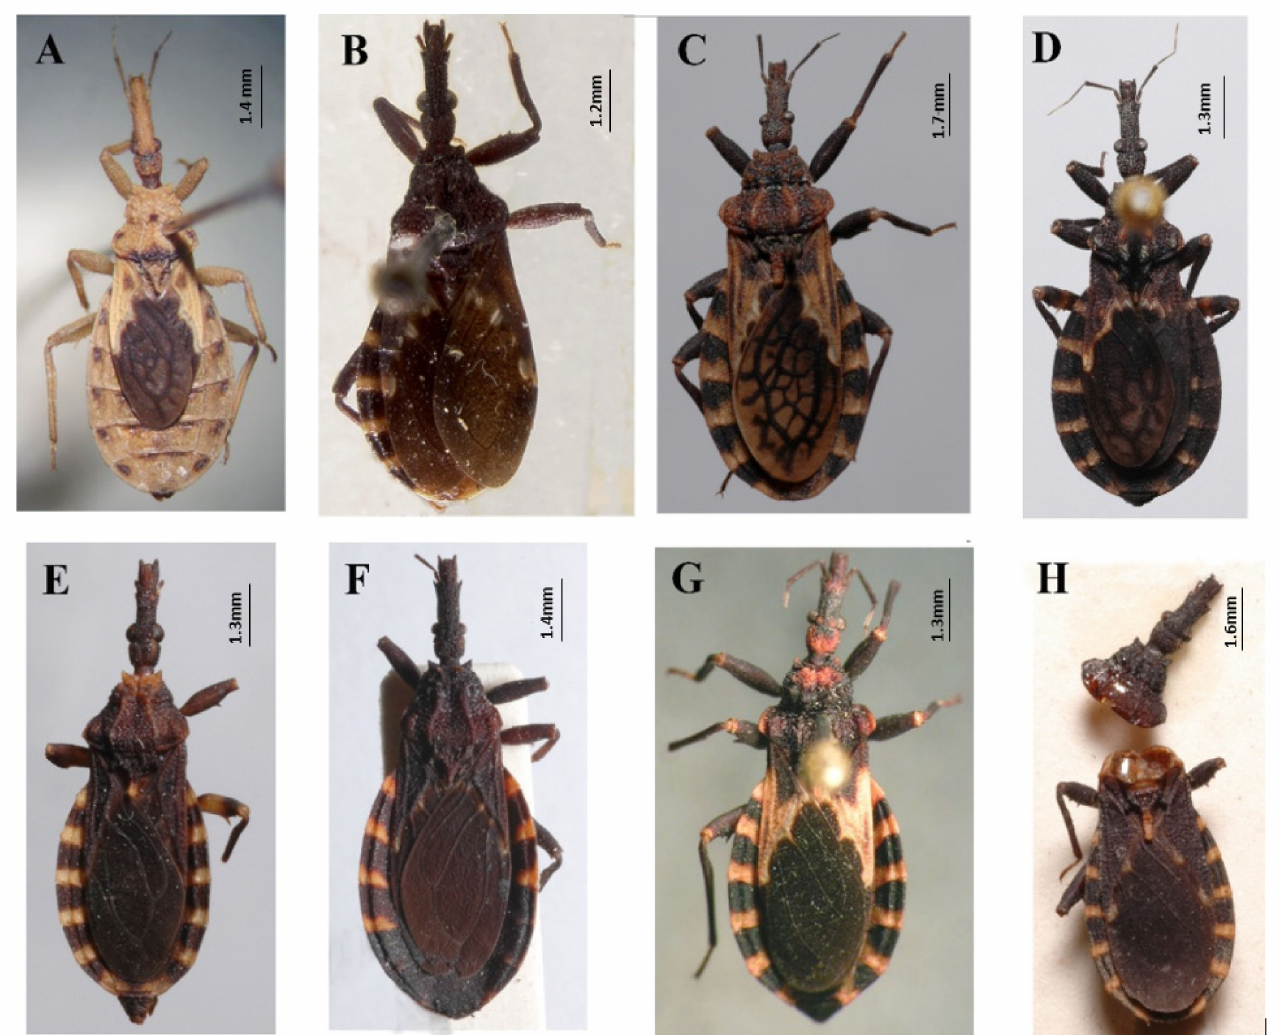
Figure 2. Eight described species of Belminus genus: ( A ) Belminus corredori Galv ã o and Angulo 2006 (male, holotype deposited in Triatominae collection, Instituto Oswaldo Cruz (CTIOC)); ( B ) Belminus costaricensis Herrer, Lent and Wygodzin- sky, 1954 (male, holotype deposited in Smithsonian Museum (NMNH), photographed by Thomas Henry); ( C ) Belminus ferroae Sandoval, Pab ó n, Jurberg and Galv ã o, 2007 (male, holotype deposited in CTIOC); ( D ) Belminus herreri Lent and Wygodzinsky, 1979 (female deposited in CTIOC); ( E ) Belminus laportei Lent, Jurberg and Carcavallo, 1995 (female paratype deposited in CTIOC); ( F ) Belminus peruvianus Herrer, Lent and Wygodzinsky, 1954 (female paratype deposited in CTIOC); ( G ) Belminus pittieri Osuna and Ayala, 1993 (female, holotype deposited in Museo del Instituto de Zoolog í a Agr í cola (MIZA), photographed by Marco Giani in Osuna and Ayala, 1993); ( H ) Belminus rugulosus Stål, 1859 (male deposited in